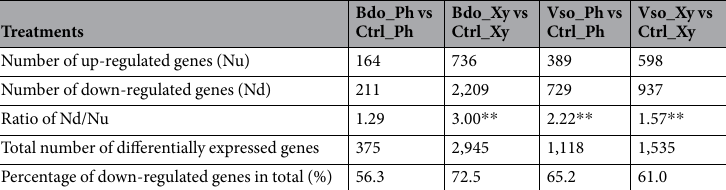
Bdo_Ph vs Ctrl_Ph